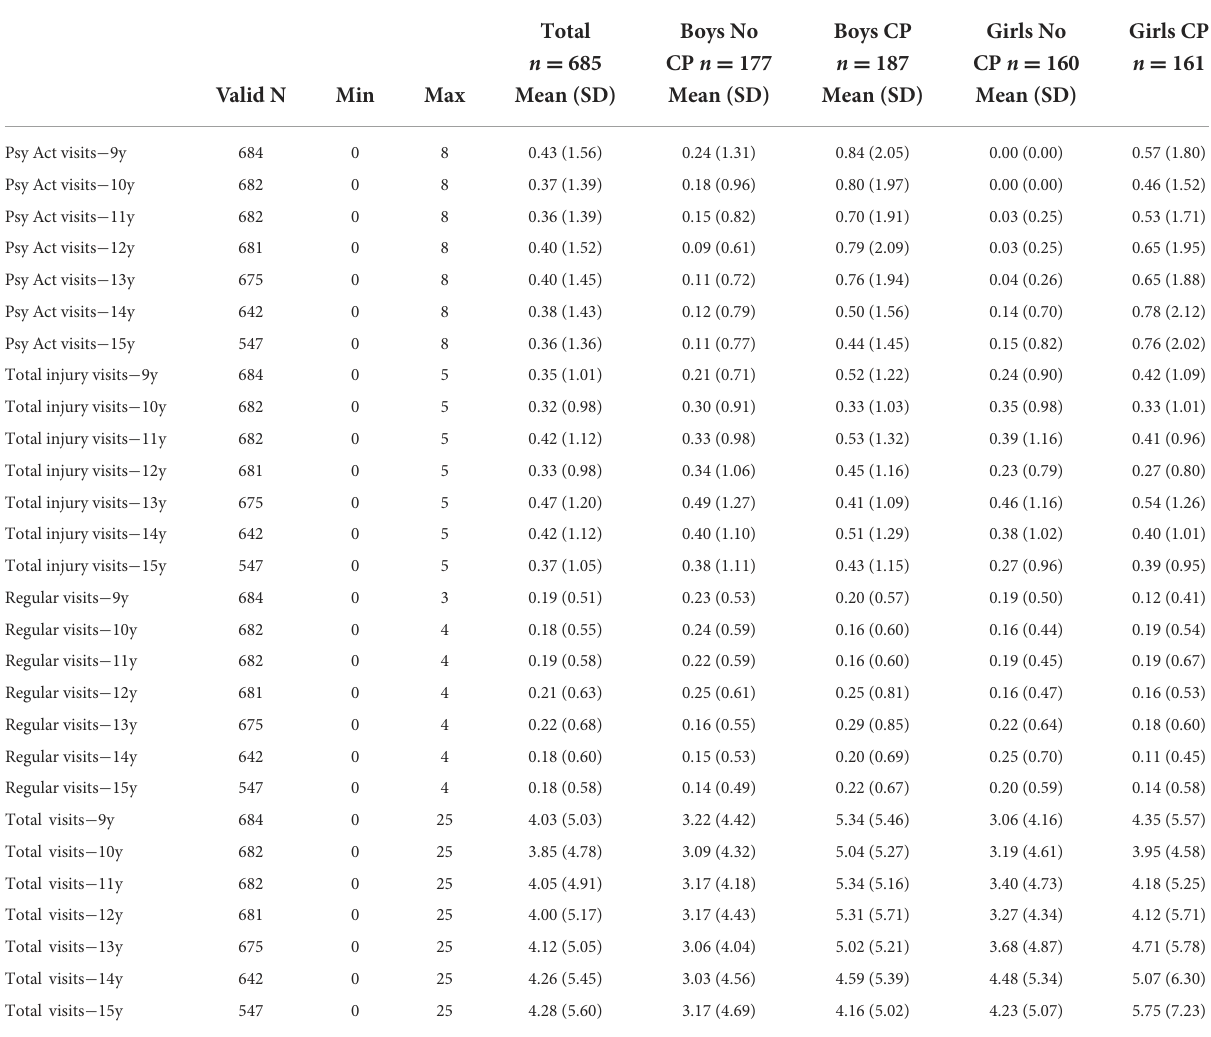
TABLE 1 Means and standard deviations for medical visits by year and sex ( N =